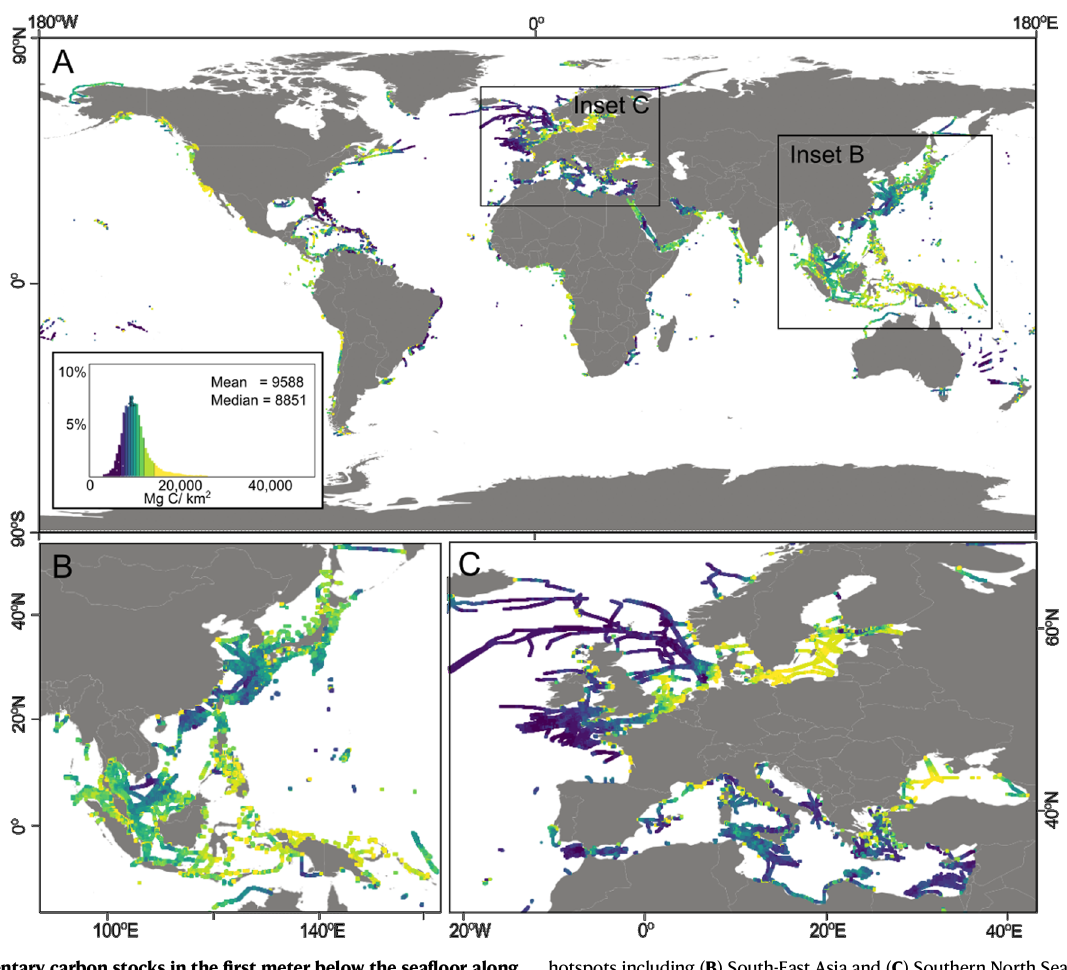
Fig. 3 | Sedimentary carbon stocks in the fi rst meter below the sea fl oor along lengths of cable routes where we assume cables are buried (i.e. 0 – 2000m